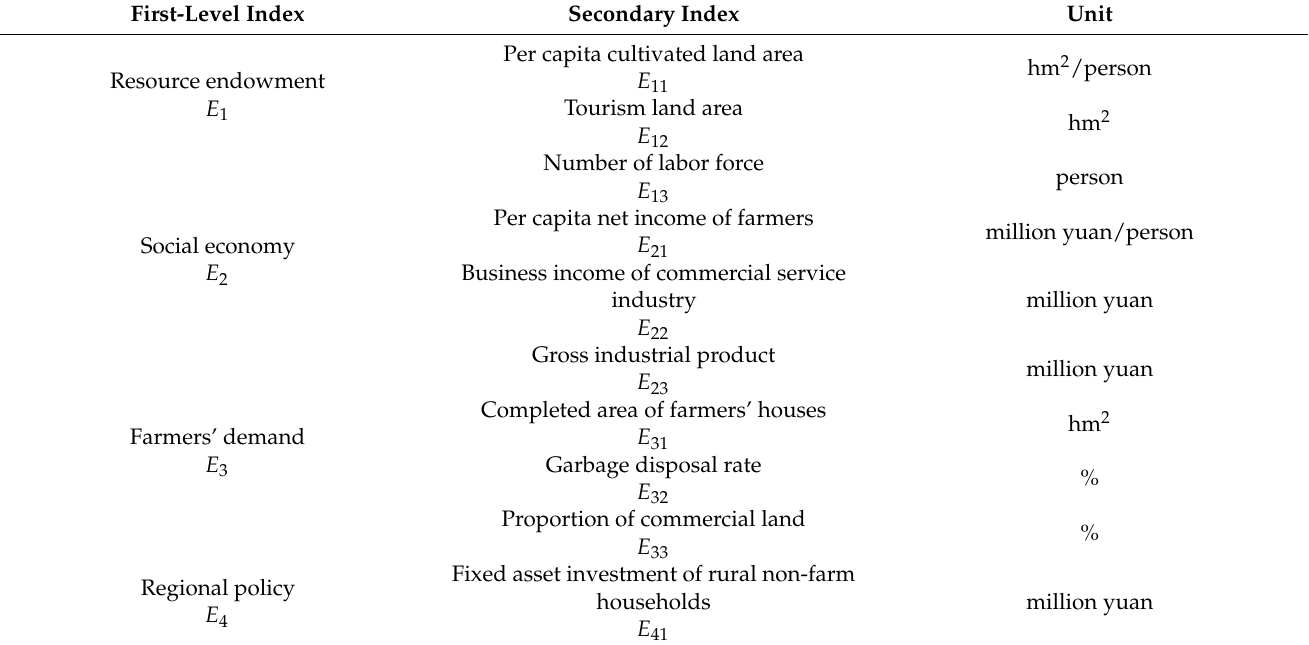
Table 6. Influencing factors of symbiosis between production land and living land in rural